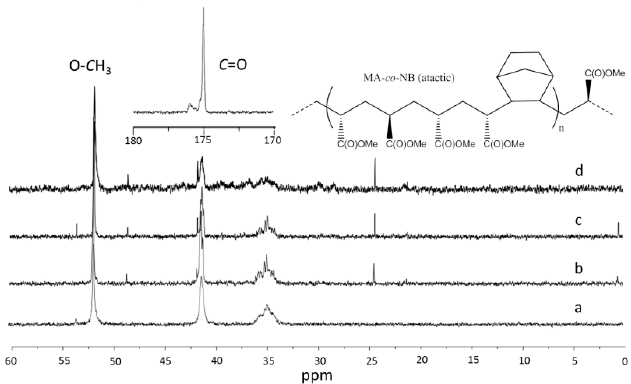
Figure 4. 1 H-NMR spectra of polymer: PMA ( a ), MA- co -NB originated from copolymerization with feed ratios of MA: NB = 9:1 ( b ), MA:NB = 7:3 ( c ), MA:NB = 5:5 ( d ).